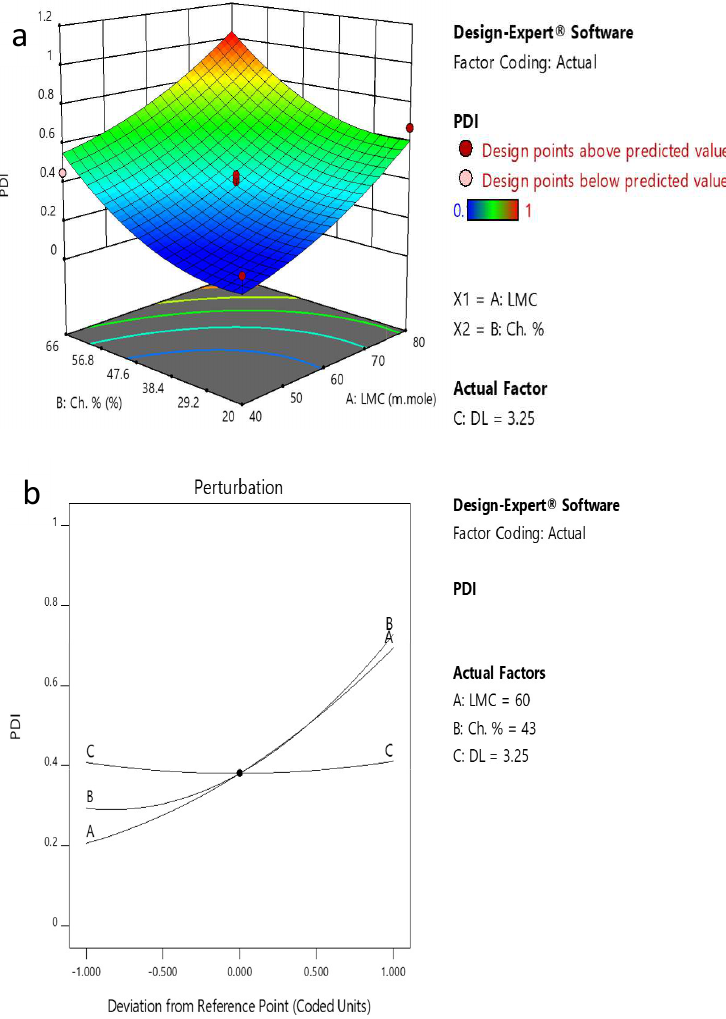
Figure 4. ( a ) 3D plot showing the effect of CH% and LMC on PDI. ( b ) Perturbation plot of factors affecting PDI.